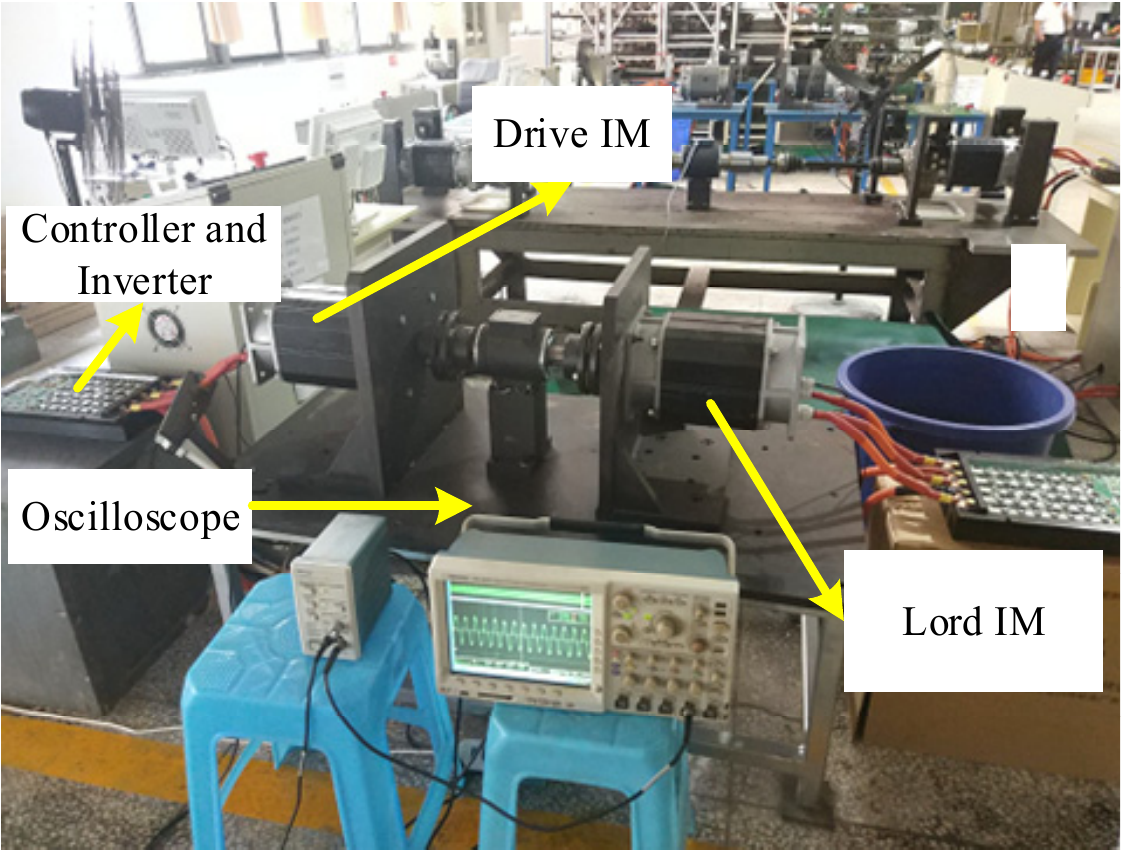
Figure 22. Experimental prototype.